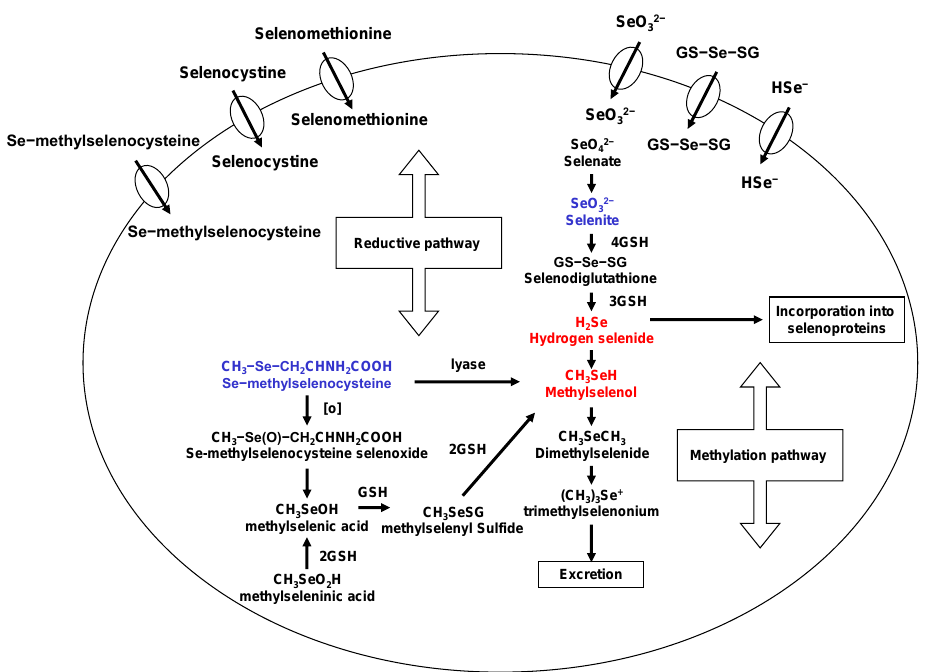
Figure 1. Selenium metabolism.